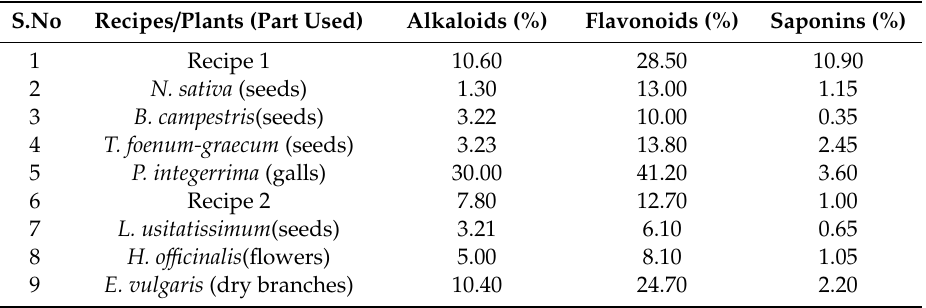
Table 1. Quantitative phytochemical screening of alkaloids, flavonoids and saponins of Recipe 1, Recipe 2 and their individual plants.